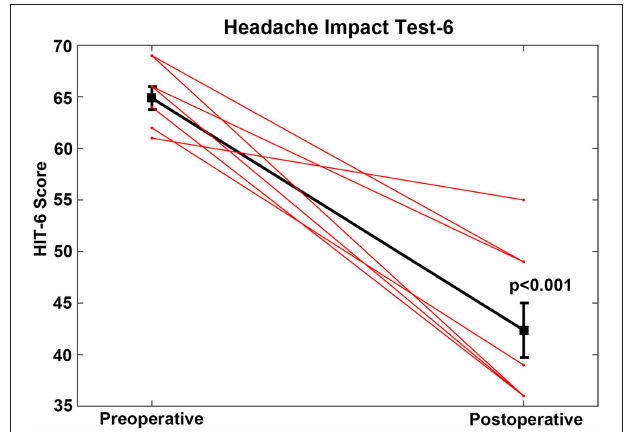
FIGURE 4 | For the cochlea-facial nerve dehiscence cohort who had round window reinforcement procedures performed, the pre-operative mean HIT-6 score was 64.9 (SE 1.1, range 52–69). The post-operative mean HIT-6 score was 42.4 (SE 2.7, range 36–55). This improvement was highly statistically significant (paired t -test, p < 0.001). These data are plotted as a single black line. Individual patients are plotted as separate lines (red). Copyright © P.A. Wackym, used with